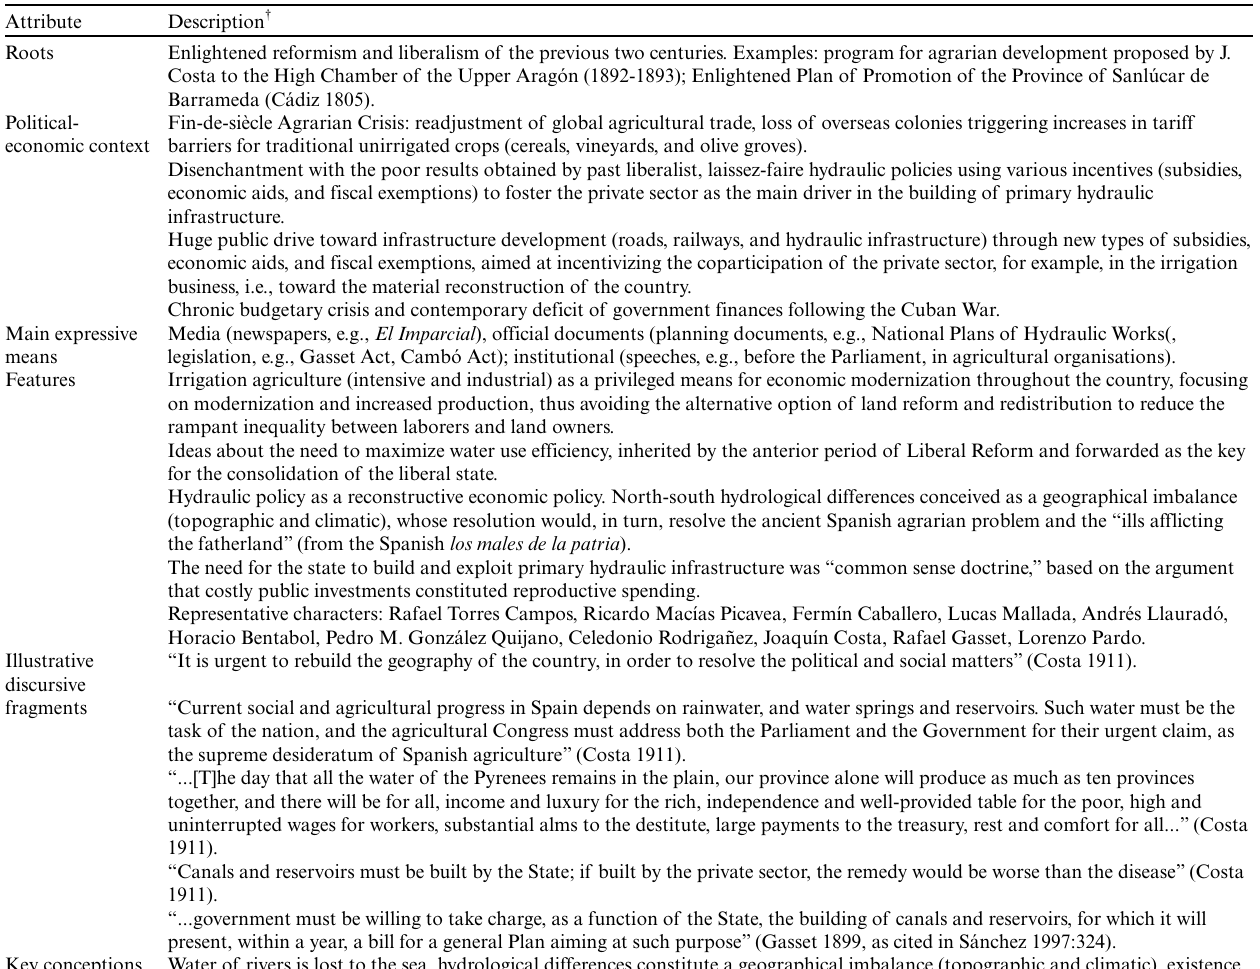
Table 1 . Main attributes of the hydraulic-irrigation regenerationist